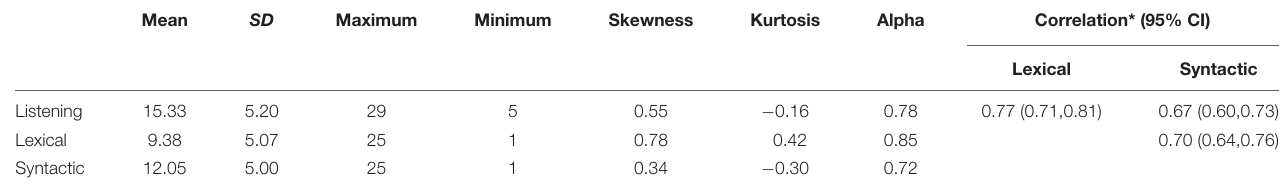
TABLE 1 | Descriptive statistics, reliabilities, and correlations ( n =